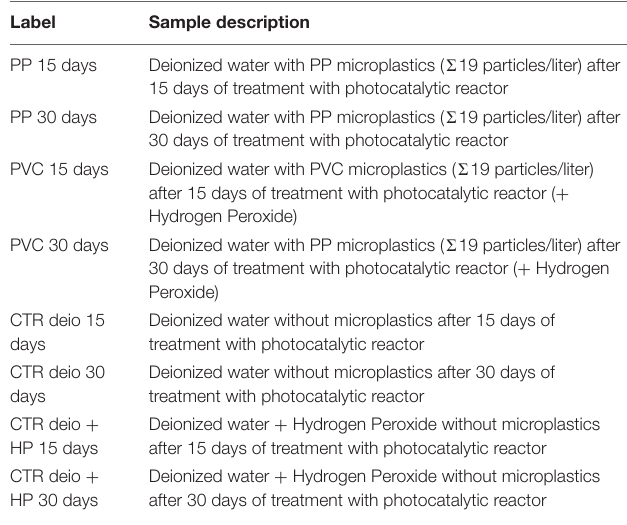
TABLE 1 | List of samples (containing in pre-treatment water a microparticles concentration corresponding to “real case” conditions: (cid:54) 19 particles/liter) used for the ecosafety screening of photocatalytic